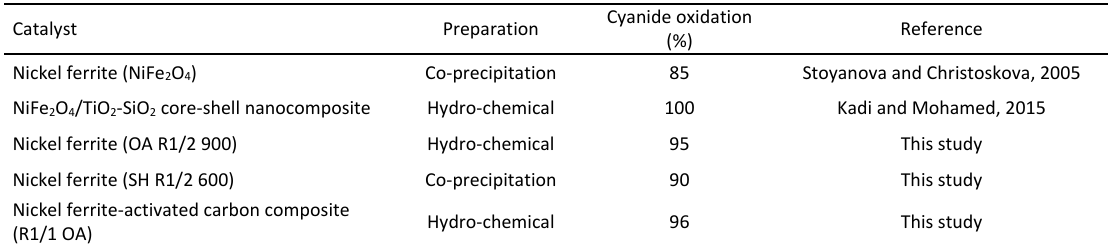
Table 5: Comparison of the oxidation capacities of the cyanide ion of different catalysts Catalyst